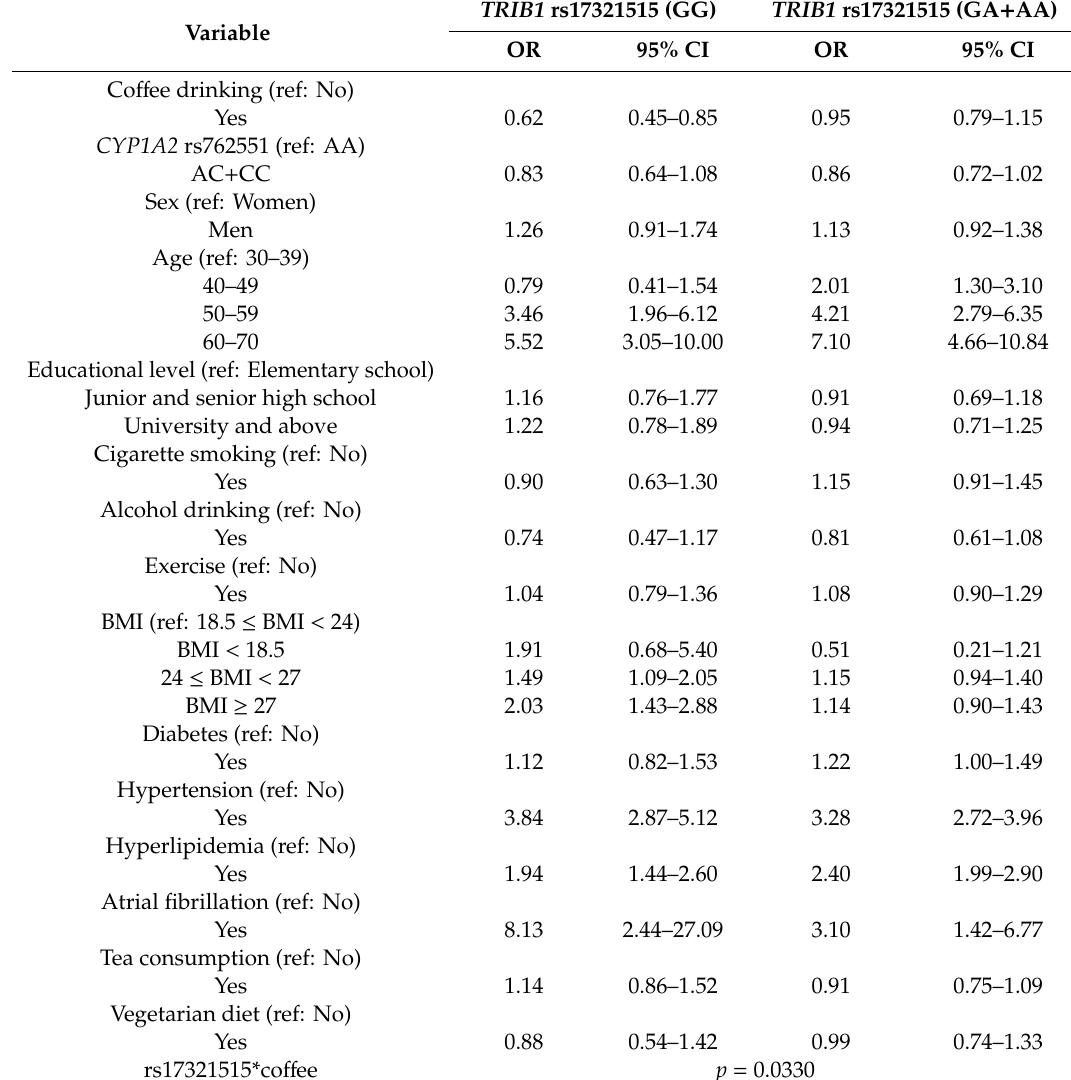
Table 4. Association of CHD with co ff ee drinking stratified by rs17321515 genotypes.